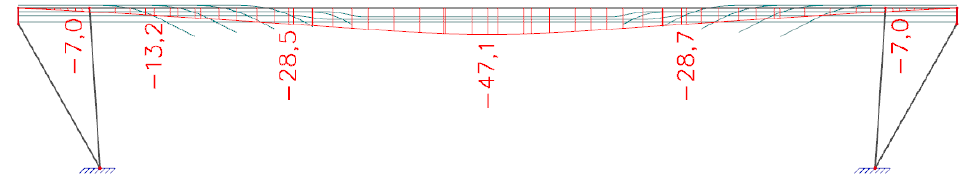
Figure 15. Deflection [mm] resulting from the rheology of concrete after 62 years of service.